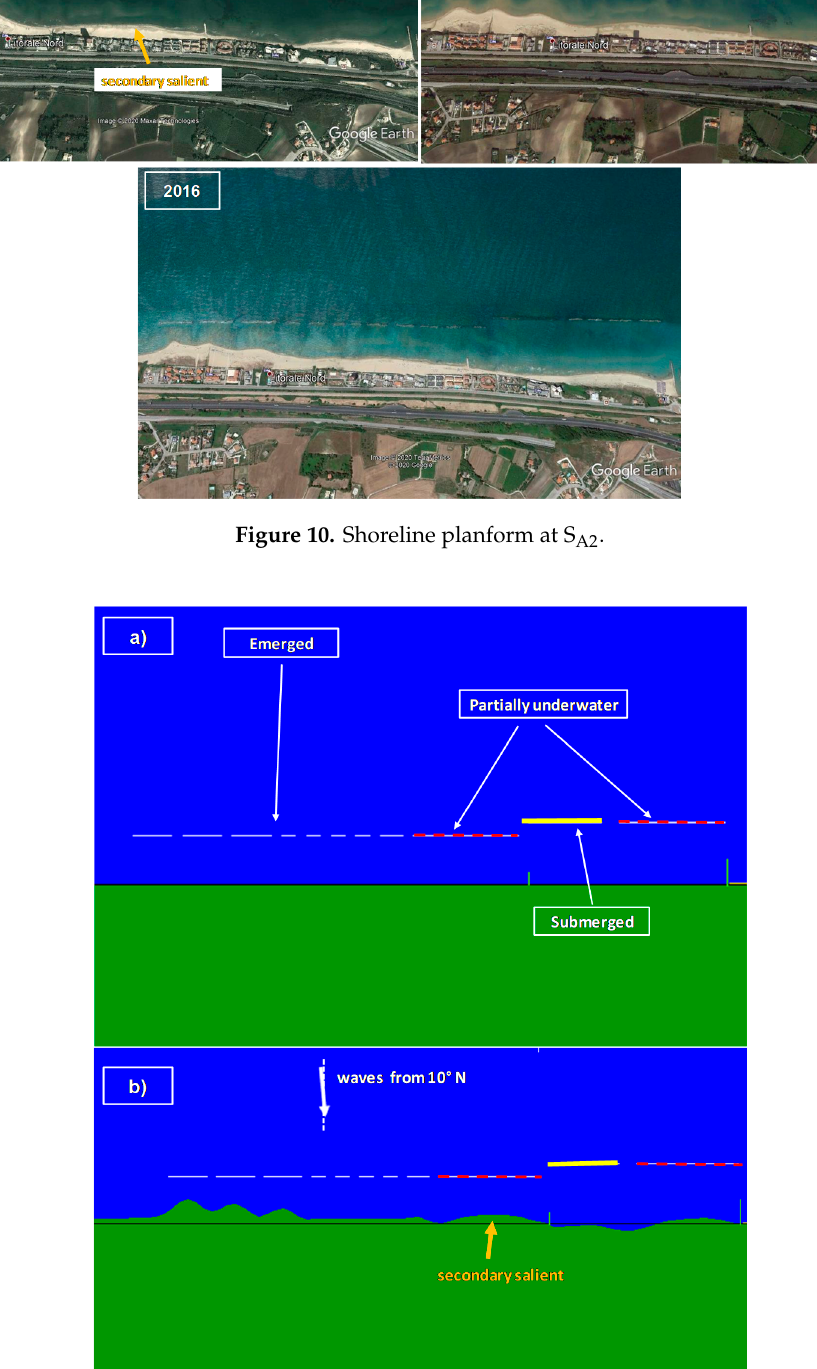
Figure 11. ( a ) S A2 as modeled in GENESIS; ( b ) shoreline response under EW (K 1 = 0.1, K 2 = 0.15).